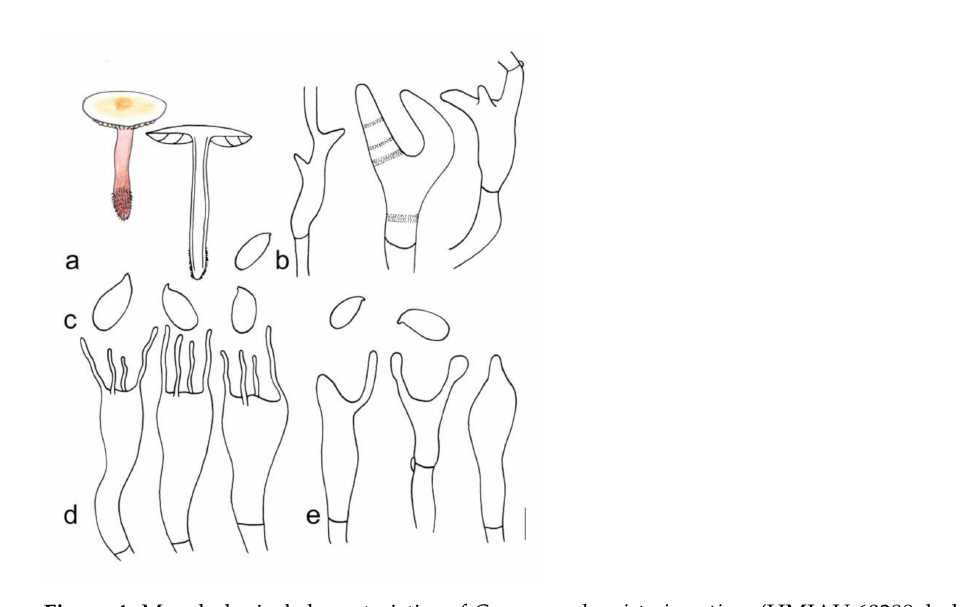
Figure 4. Morphological characteristics of Gymnopus longisterigmaticus (HMJAU 60288, holotype): ( a ) basidiomata, ( b ) pileipellis, ( c ) basidiospores, ( d ) basidia, and ( e ) cheilocystidia. Scale bars: 1 cm ( a ), 25 µ m ( b ), and 5 µ m ( c – e ). Gymnopus longus J.J. Hu, B. Zhang and Y. Li sp.